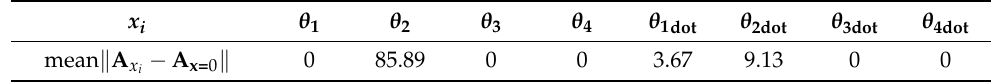
Table 2. Inspection of the source of